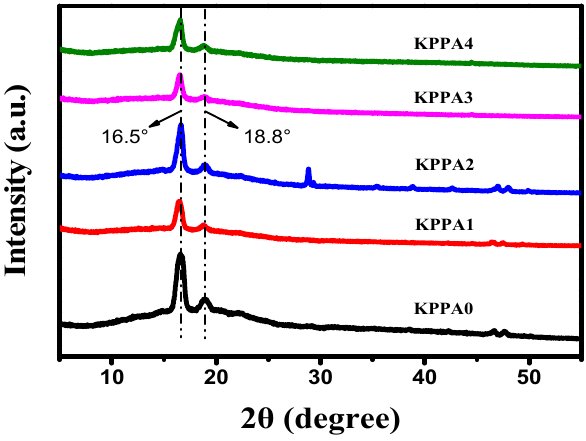
Figure 5. X-ray diffraction patterns of the KPPA0, KPPA1, KPPA2, KPPA3 and KPPA4 cryogels.